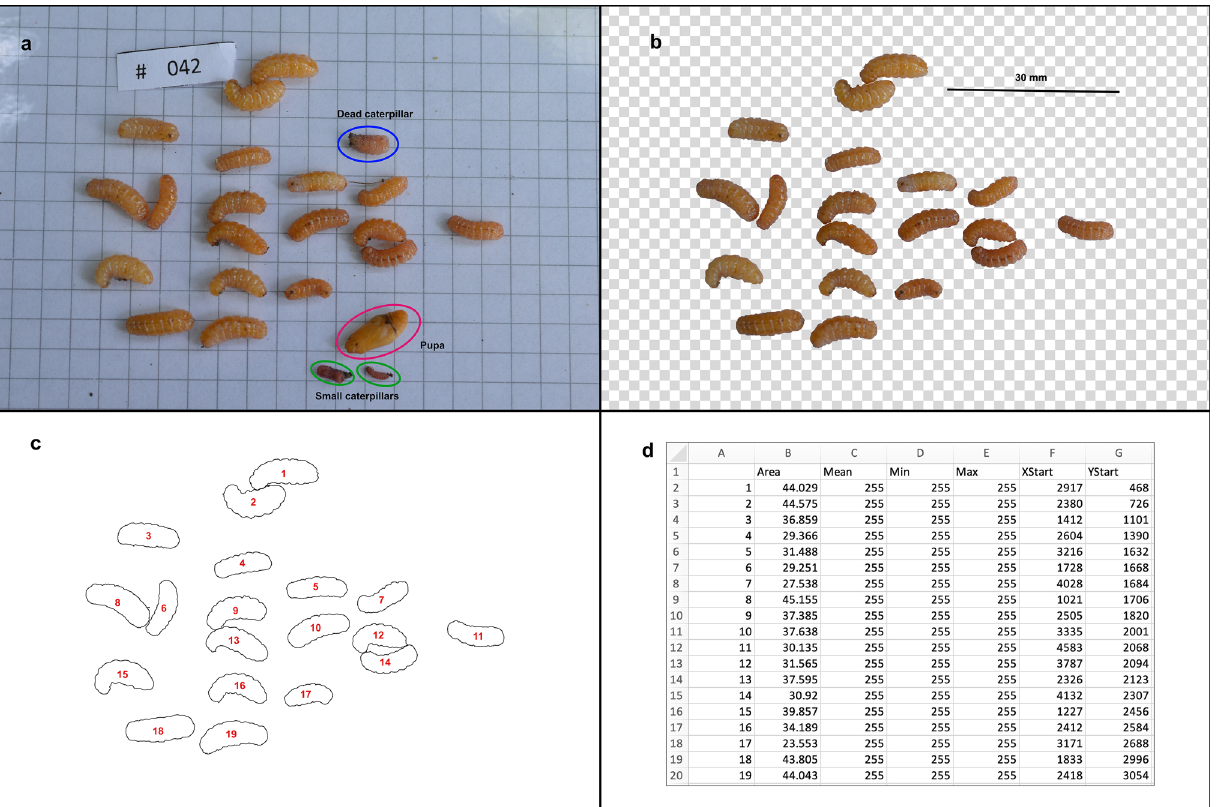
Figure 5. Summary of the procedure for measuring the size of prepupal Phengaris alcon caterpillars. ( a ) Original image taken from digital camera (by Anna Ágnes Somogyi, with 5 mm square paper background), showing 22 P. alcon caterpillars, including one clearly dead and two small caterpillars (which will pupate next year), and one P. alcon pupa. ( b ) Background and all objects other than live prepupal caterpillars removed and scale bar added (based on 5 mm squares) in Adobe Photoshop. ( c ) Tracing of perimeter of prepupal caterpillars in Fiji. ( d ) Export of details of each prepupal caterpillar from Fiji as a CSV file (here shown in Microsoft Excel), including calculated area in mm 2